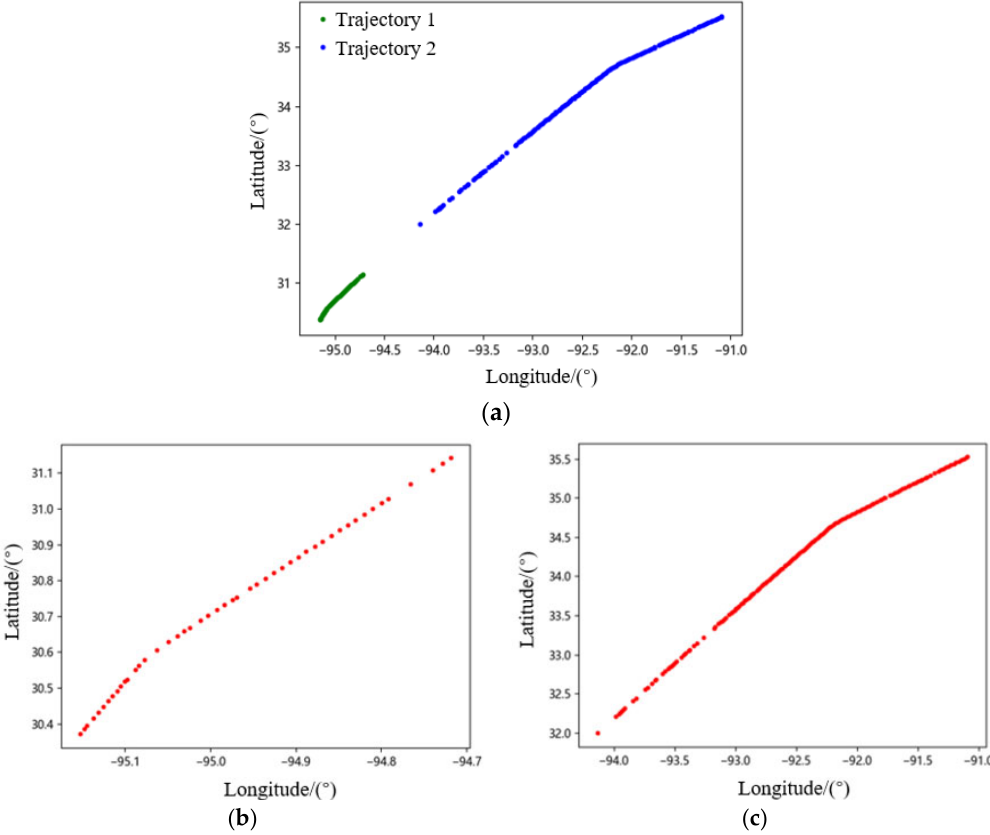
Figure 2. Trajectory reconstruction: ( a ) reconfigurable trajectory; ( b ) trajectory 1 after reconstruction; ( c ) trajectory 2 after reconstruction.